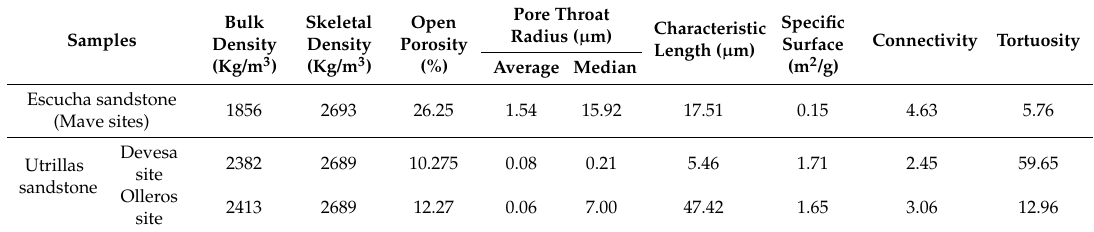
Table 5. Porosimetric parameters obtained by means of